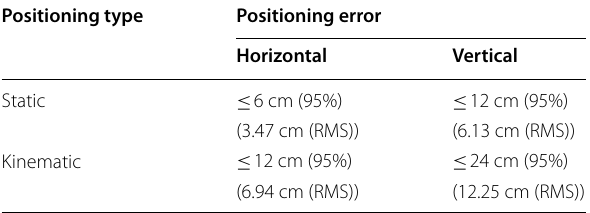
Table 3 Positioning performance of CLAS service Positioning type